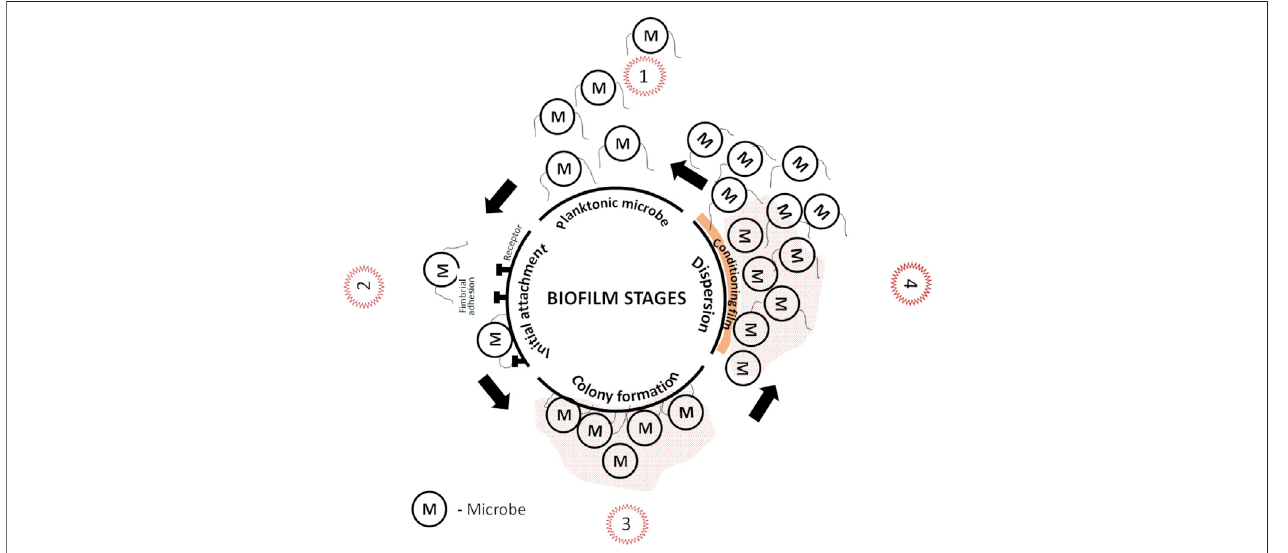
FIGURE 2 | Stages of bio fi lm